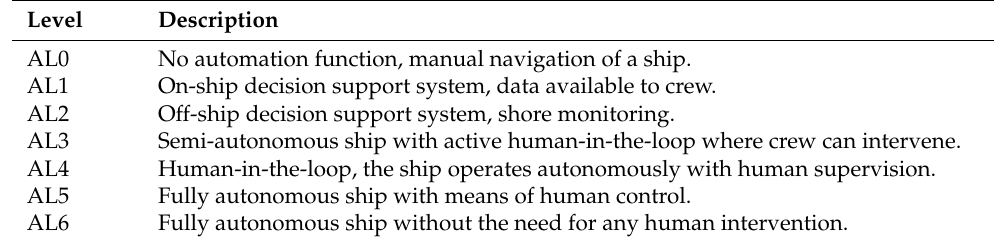
Table 1. The ship autonomy classification standard by LR.